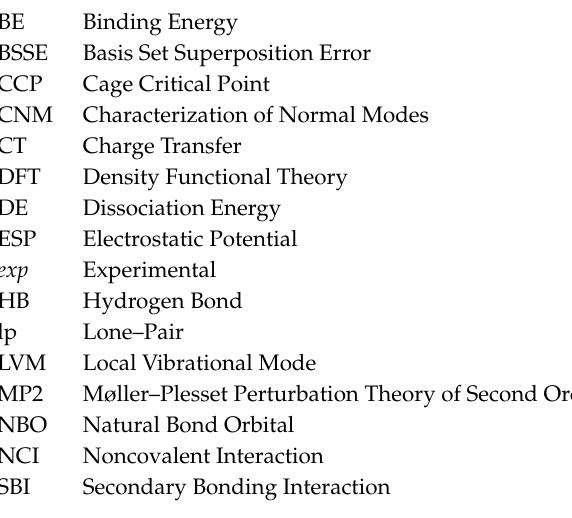
Figure S1: Description of the 9 possible local modes between the monomers of a dimeric system; Table S1: Description of the videos showing selected normal mode vibrations for R2 and system 1 . The videos are uploaded as separate files; Table S2: Cartesian atomic coordinates of optimized equilibrium geometries for all model